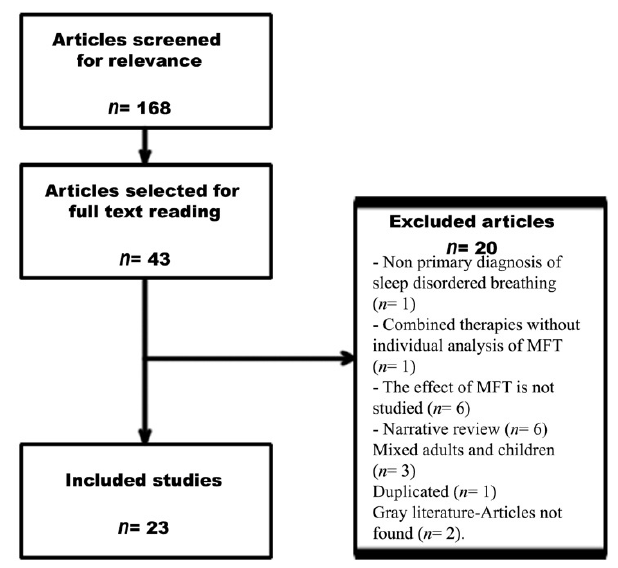
Figure 1. PRISMA flow chart.